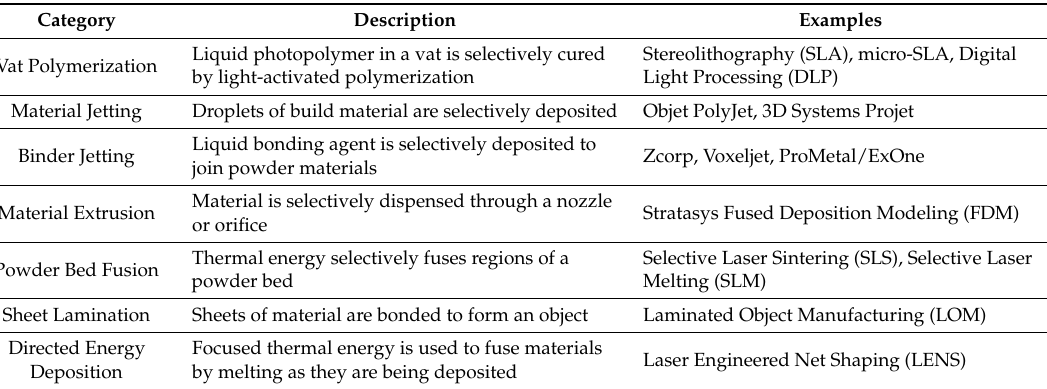
Table 1. Categories of Additive Manufacturing